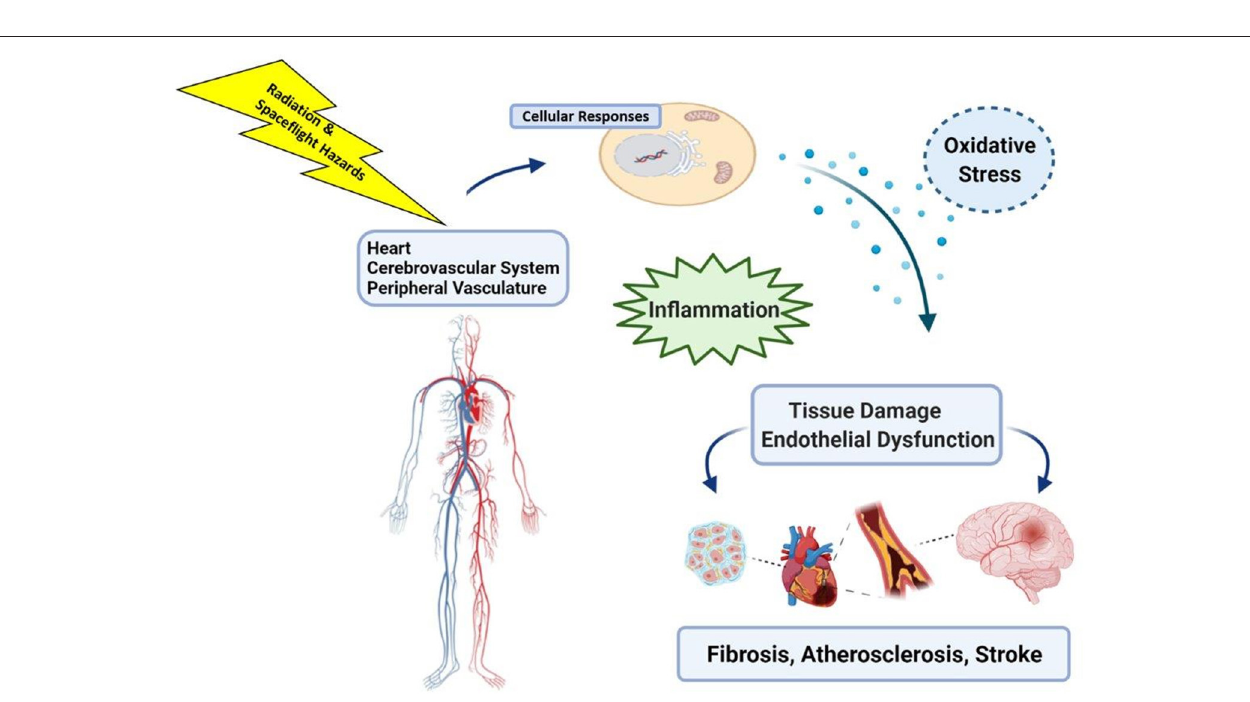
FIGURE 2 | Space radiation, and exposure to other hazards of spaceflight such as microgravity, can induce cell and tissue level changes that include oxidative stress and inflammatory responses in the heart and vasculature that may impact long-term cardiovascular health. Image created with Biorender.com.